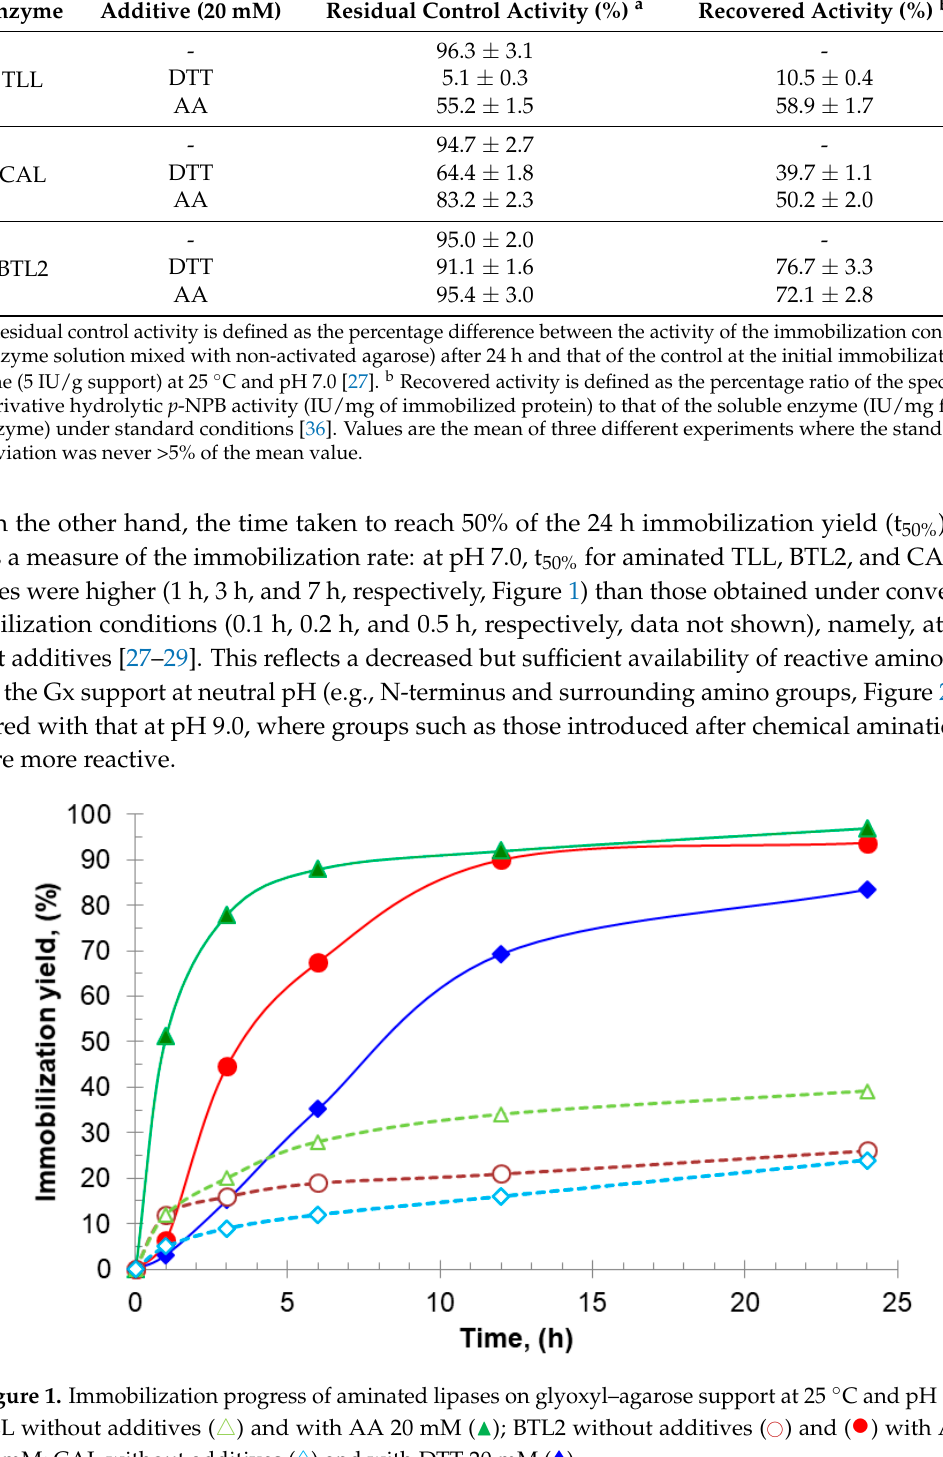
• ) and ( ) with AA (cid:35)